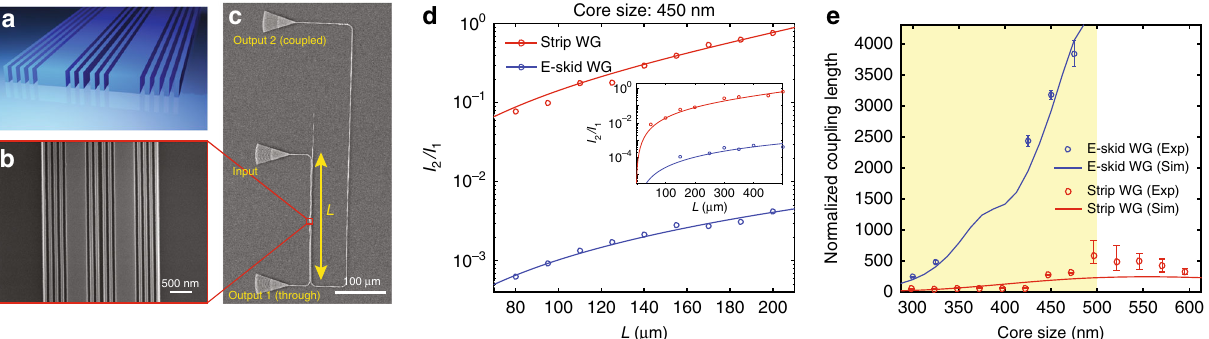
Fig. 4 Cross-talk in e-skid waveguides. a Schematic of coupled e-skid waveguides on an SOI platform. The waveguide height, center-to-center separation between the two waveguides ( s ), and Λ are 220 nm, 1000 nm, and 120 nm, respectively. A cladding oxide is also added on the top of the waveguides. The number of ridges between the waveguides is dictated by the waveguide core size. b Top view SEM image of the coupled e-skid waveguides. c The experimental setup to measure the cross-talk between the two waveguides at the telecommunication wavelength ( λ = 1550 nm). Light is in-coupled to the fi rst waveguide through the middle grating coupler. The second waveguide is coupled to the fi rst waveguide for a length of L . In this experiment, the bending radius is 5 μ m, hence, we can ignore the bending loss. d The ratio between the measured output powers for strip waveguide and e-skid waveguide vs. L at the telecommunication wavelength. The ratio for the e-skid waveguide is two orders of magnitude lower, indicating that far less power is coupled to the second waveguide. The inset shows the ratio for the waveguides without the top cladding oxide. In this case, the metamaterial cladding can increase the coupling length up to 30 times or reduce the cross-talk -30 dB. See Supplementary Figure 8 for more details. e Comparison of the simulated and measured coupling length for e-skid waveguides and strip waveguides. The coupling length is normalized to the wavelength. Error bars represent the standard deviation of the fi tting curves. The optimum match between the simulation and experiment is achieved when ρ = 0.6 for the cladding of e-skid waveguides. The coupling length for e-skid waveguides is an order of magnitude larger in comparison with strip waveguides (shaded region). The coupling length for strip waveguides with larger core size decreases because the overlap between the evanescent tails is increased although more power is con fi ned inside the core (unshaded Figure 3a emphasizes the counterintuitive nature of the con fi nement caused by anisotropic media which beats the con fi nement of conventional high index-contrast interface consisting of silicon surrounded by vacuum (blue curve in Fig. 3a). As it is seen in Fig. 3a, if we increase the index of the cladding only in the z direction, whereas the index in the other directions are fi xed, the evanescent wave decays faster in the cladding and the skin-depth reduces drastically. Note, the average cladding index increases but the mode decay length decreases.